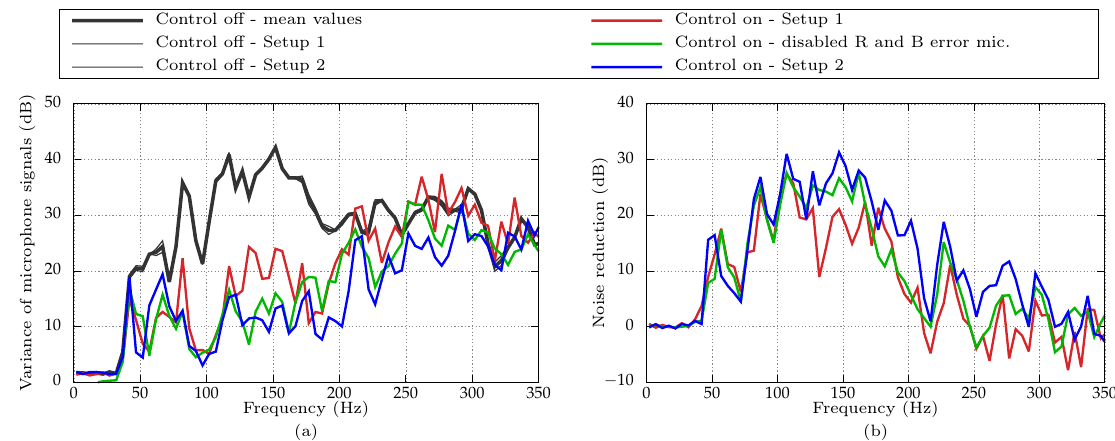
Figure 16. ( a ) The average variance of the room microphone signals for each of the primary noise tones with and without active control and ( b ) the averaged noise reduction for the noise sensed by the room microphones for each of the primary noise tones. For Setup 1, Setup 2 and Setup 1 with the error microphones B and R disabled, d 1 = 0.1 m.